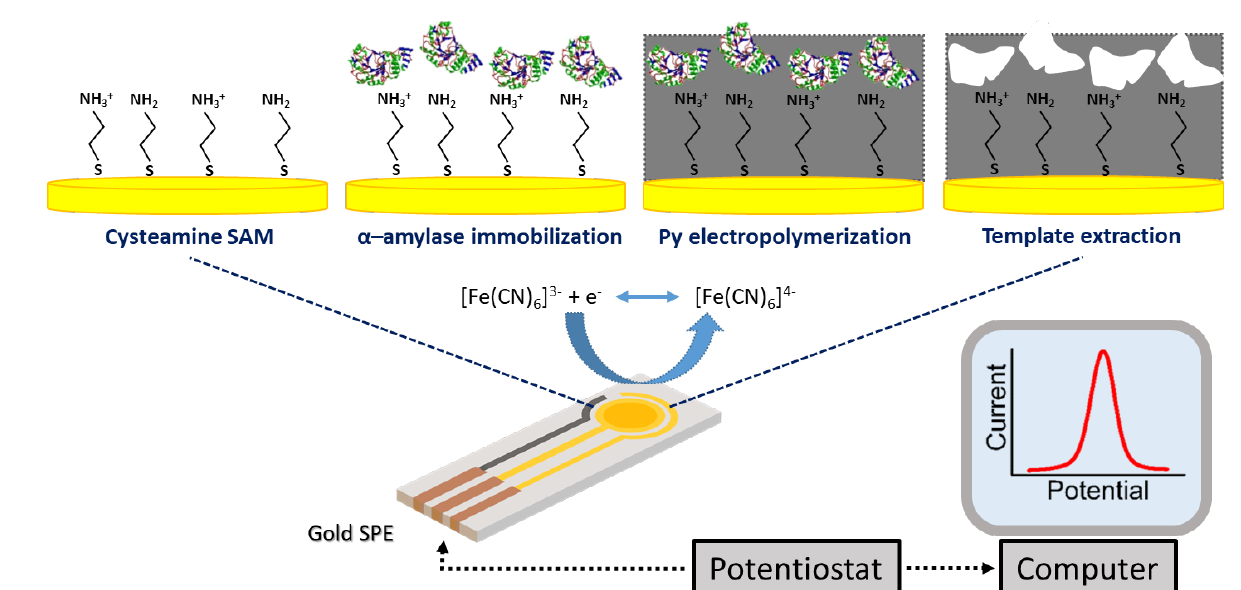
Figure 1. Schematic representation of the synthetic process for preparation of the MIP film at the AuSPE surface. The overall process incorporates the following steps: (i) adsorption of a cysteamine (CA) SAM on the electrode working area for (ii) immobilization of template biomolecules; (iii) imprinting process by electrosynthesis of a poly(pyrrole) thin film in the presence of template molecules; (iv) removal of target biomolecules from the polymeric matrix.